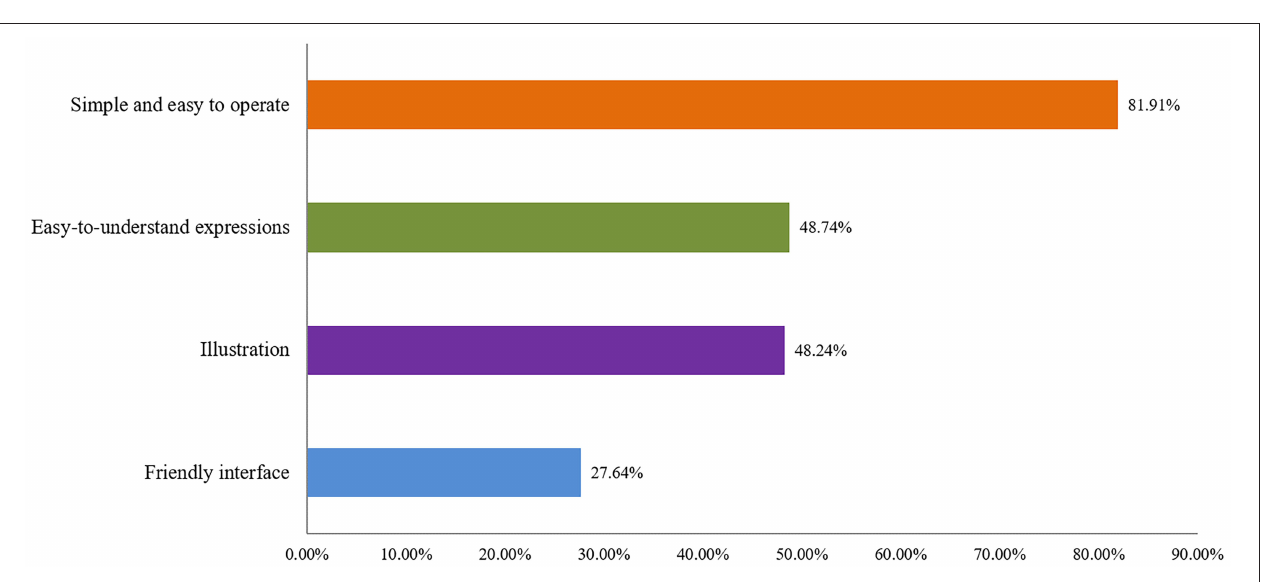
FIGURE 2 | Expectation on the improvement of the Wechat applet for